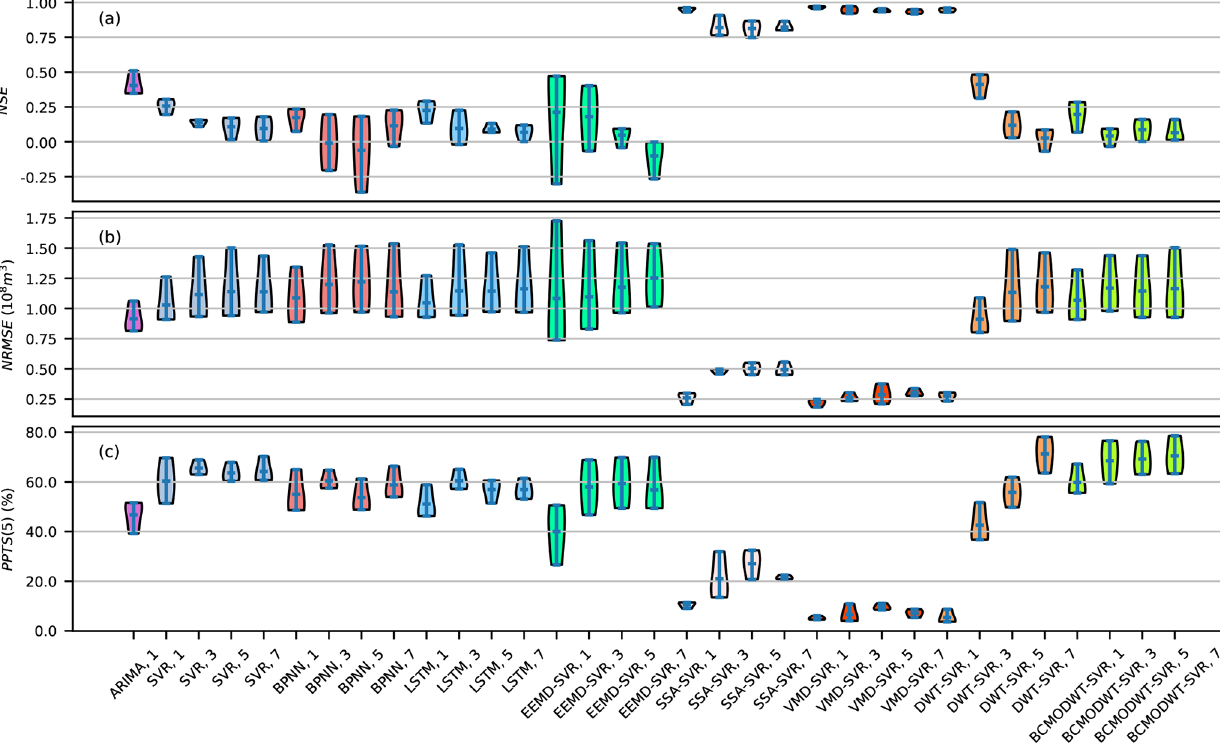
Figure 20. Violin plots of the evaluation criteria during testing for the TSDP and benchmark models (the horizontal axes represent the model and lead time; e.g., “VMD-SVR, 1” represents the VMD-SVR model for 1-month-ahead runoff